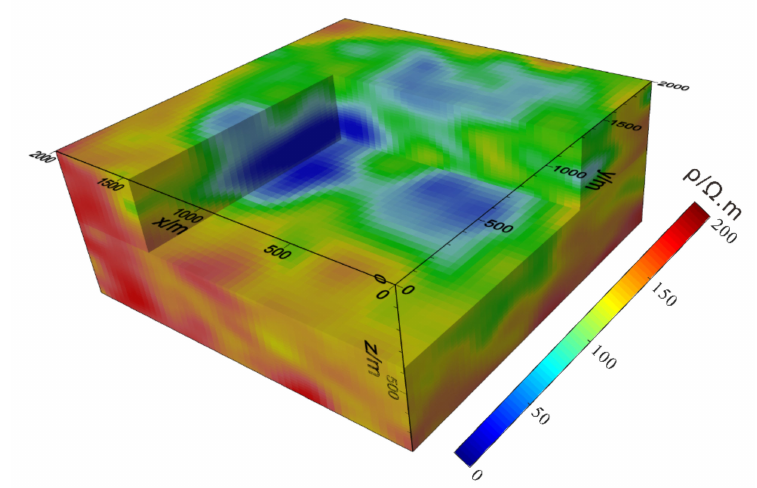
Figure 13. 3D inversion result produced by the PSO-GD algorithm.